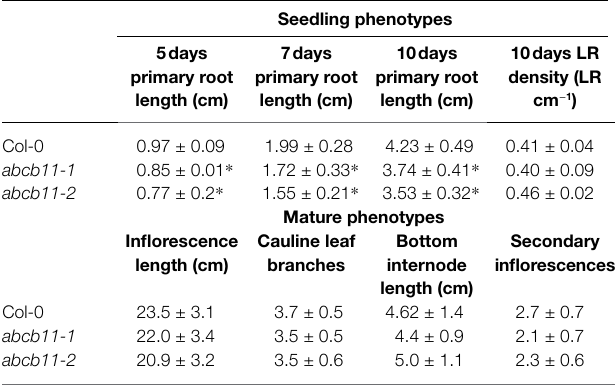
TABLE 2 | Phenotypic analysis of abcb11